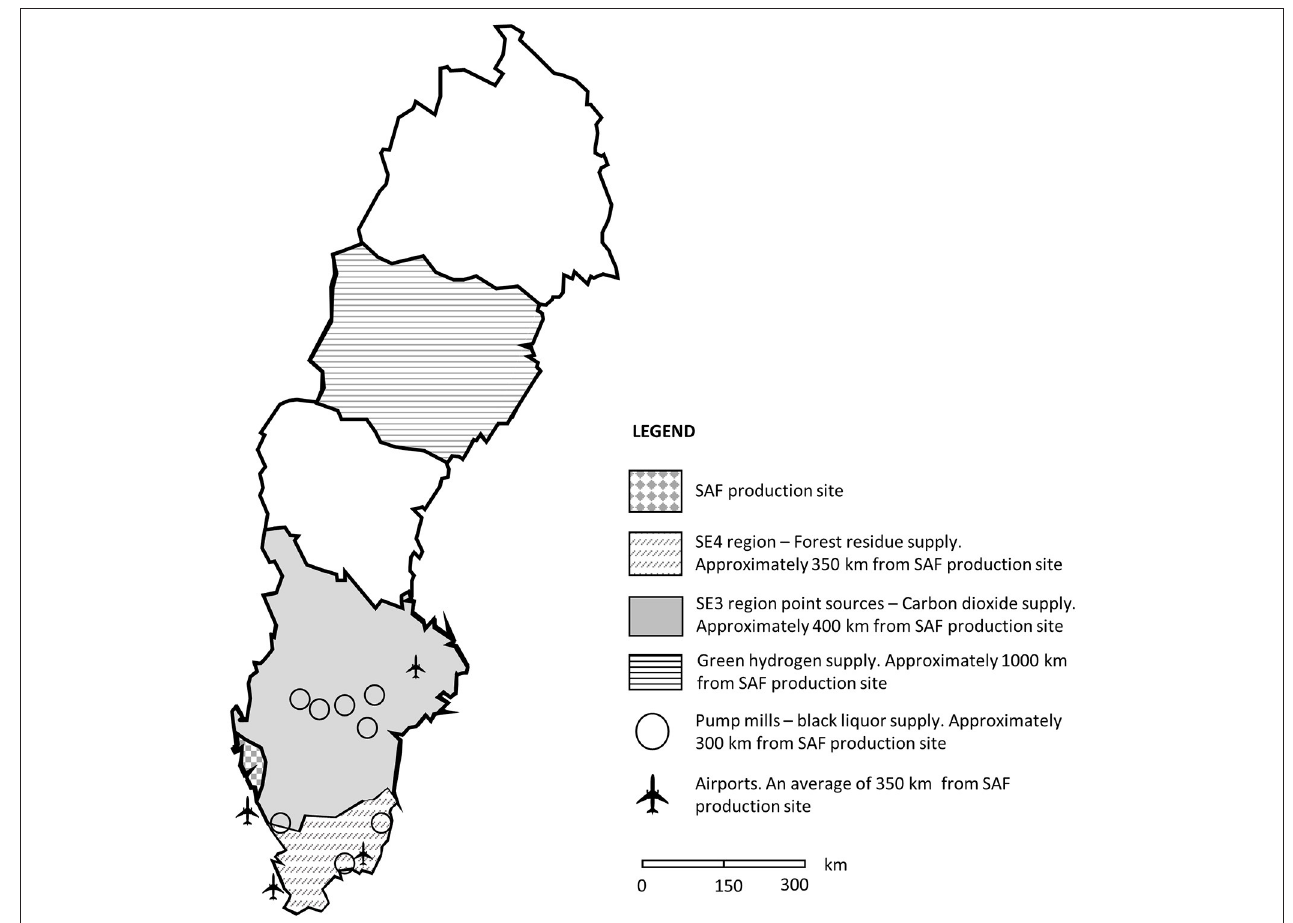
FIGURE 6 | Map of Sweden with locations of potential SAF production sites, potential feedstock supply sites and location of average Swedish